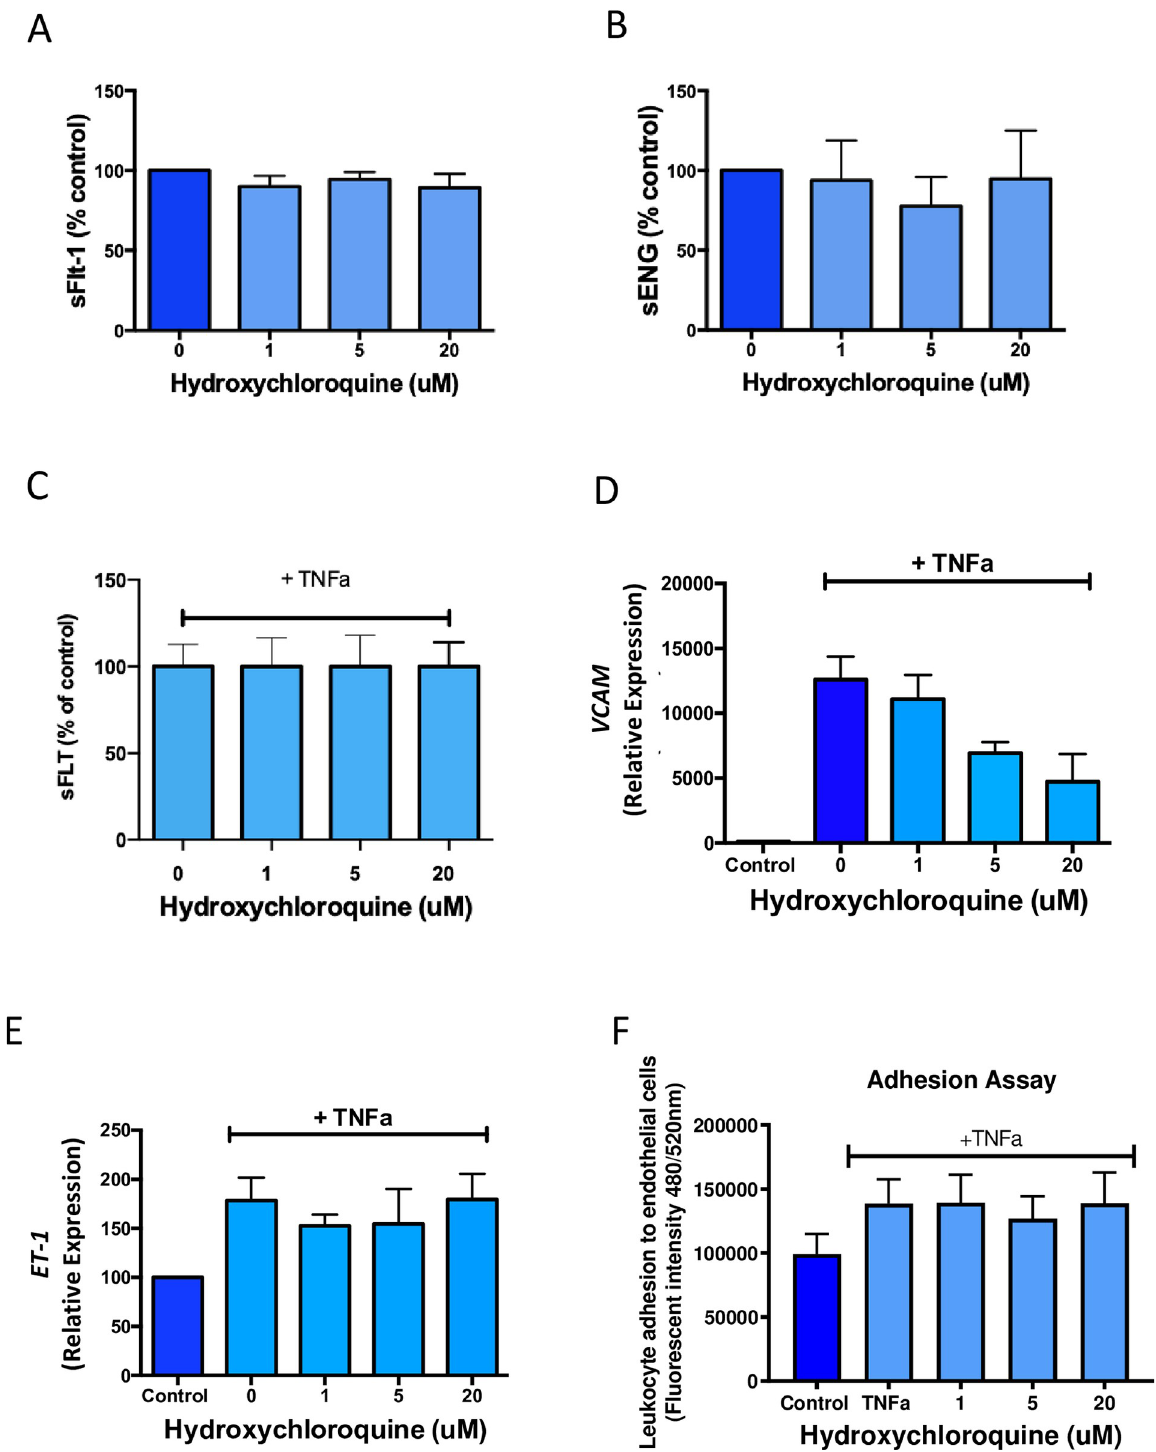
Fig 4. The effects of hydroxychloroquine on HUVEC secretion of sFlt-1 and sENG and endothelial cell dysfunction gene markers. Hydroxychloroquine treatment of HUVECs did not change sFlt-1 (a) or sENG (b) secretion. Hydroxychloroquine did not reduce sFlt-1 secretion in the presence of TNF α . TNF α stimulation significantly increases VCAM (d) and ET1 (e) expression in HUVECs, compared to untreated control cells. Hydroxychloroquine treatment appeared to lower VCAM expression, in a non-significant dose dependent manner (d), however, ET1 levels remain unchanged (e). Adhesion of monocytes to HUVECs increases under TNF α stimulation and hydroxychloroquine treatment does not reliably reverse this outcome (f). Data are means ± SEM of minimum three independent experiments. https://doi.org/10.1371/journal.pone.0271560.g004 PLOS ONE | https://doi.org/10.1371/journal.pone.0271560 November23,